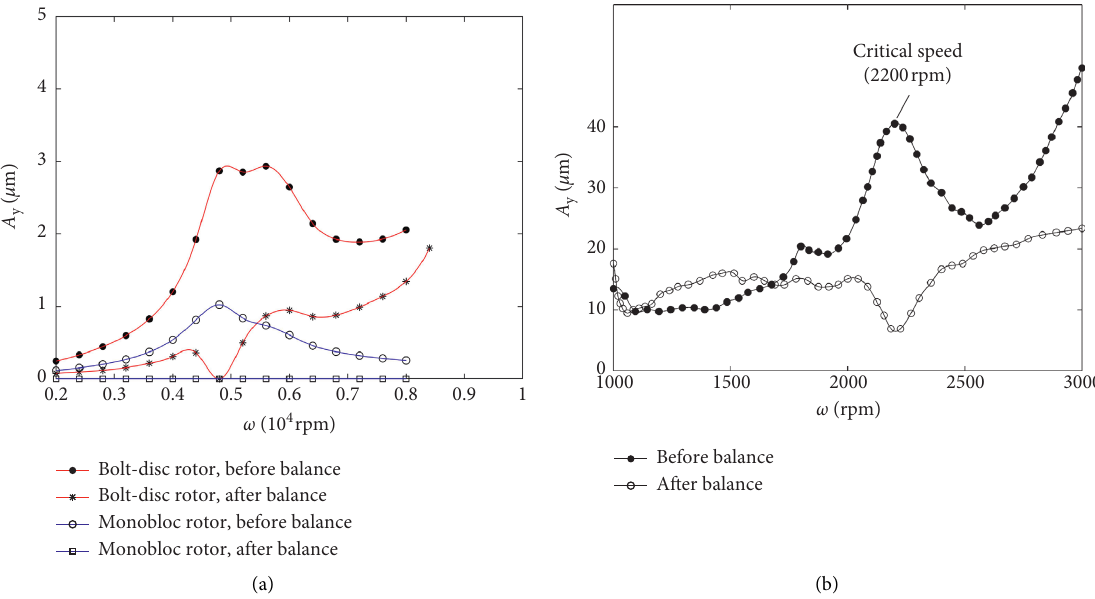
Figure 8: Vibration for bolt-disc rotor and F-class gas turbine rotor: (a) vibration for bolt-disc rotor and (b) vibration for the F-class gas turbine rotor.